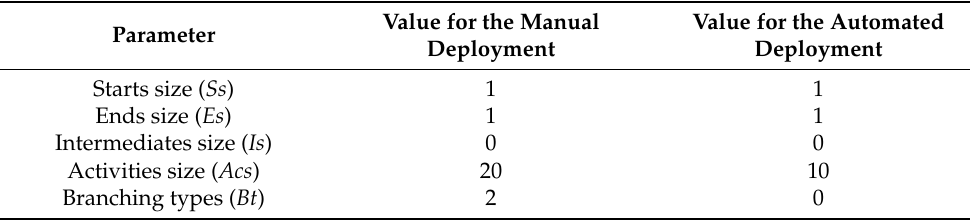
Table 7. Components of the Yaqin complexity for the two deployment processes. Value for the Manual Value for the Automated Component Deployment Deployment Number of nodes ( Ns ) 24